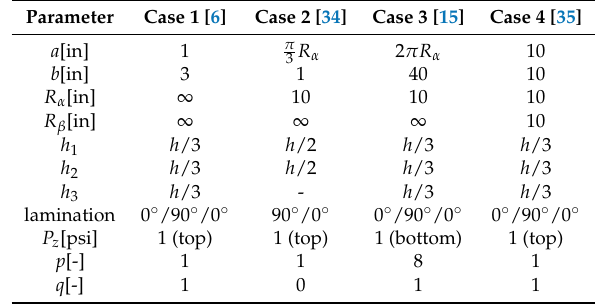
Table 2. Load and geometrical data for the analyzed cases. Case 1 takes into consideration the rectangular composite plate proposed by Pagano [6], Case 2 is about the composite laminated cylindrical panel proposed by Ren [34], Case 3 regards the composite laminated cylinder by Varadan and Bhaskar [15], and Case 4 deals with the composite laminated spherical panel proposed by Fan and Zhang